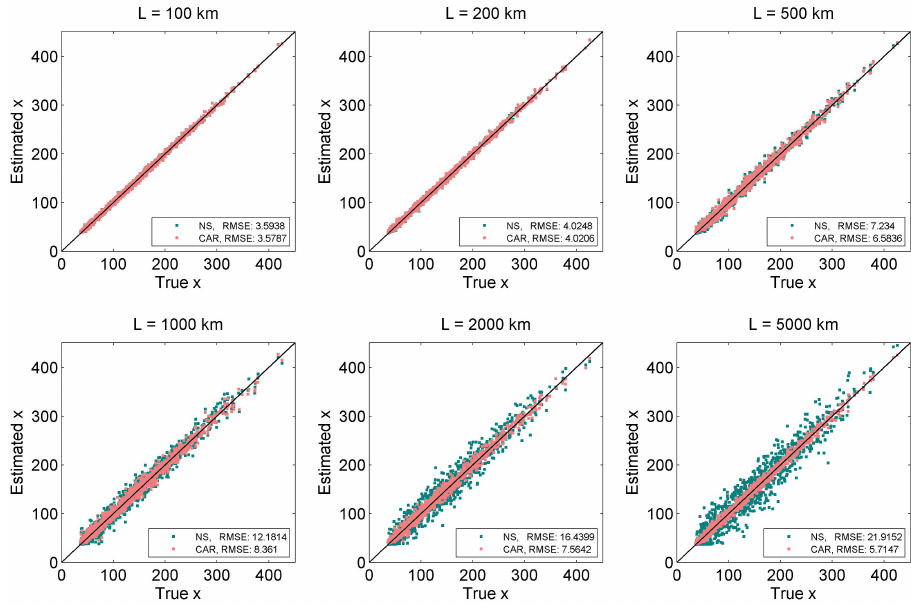
Fig. 6. Scatter plots as in Fig. 5 now for the BIOM Southern Africa (BIOM-SAF) source